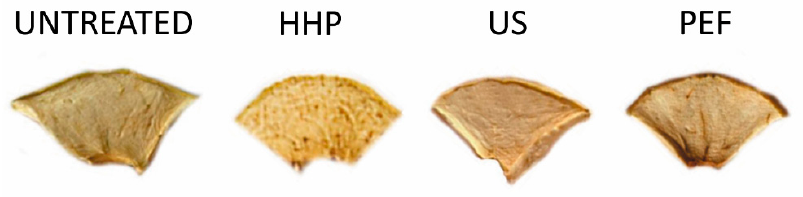
Figure 3. Air-dried apples untreated and treated with HPP, US and PEF.